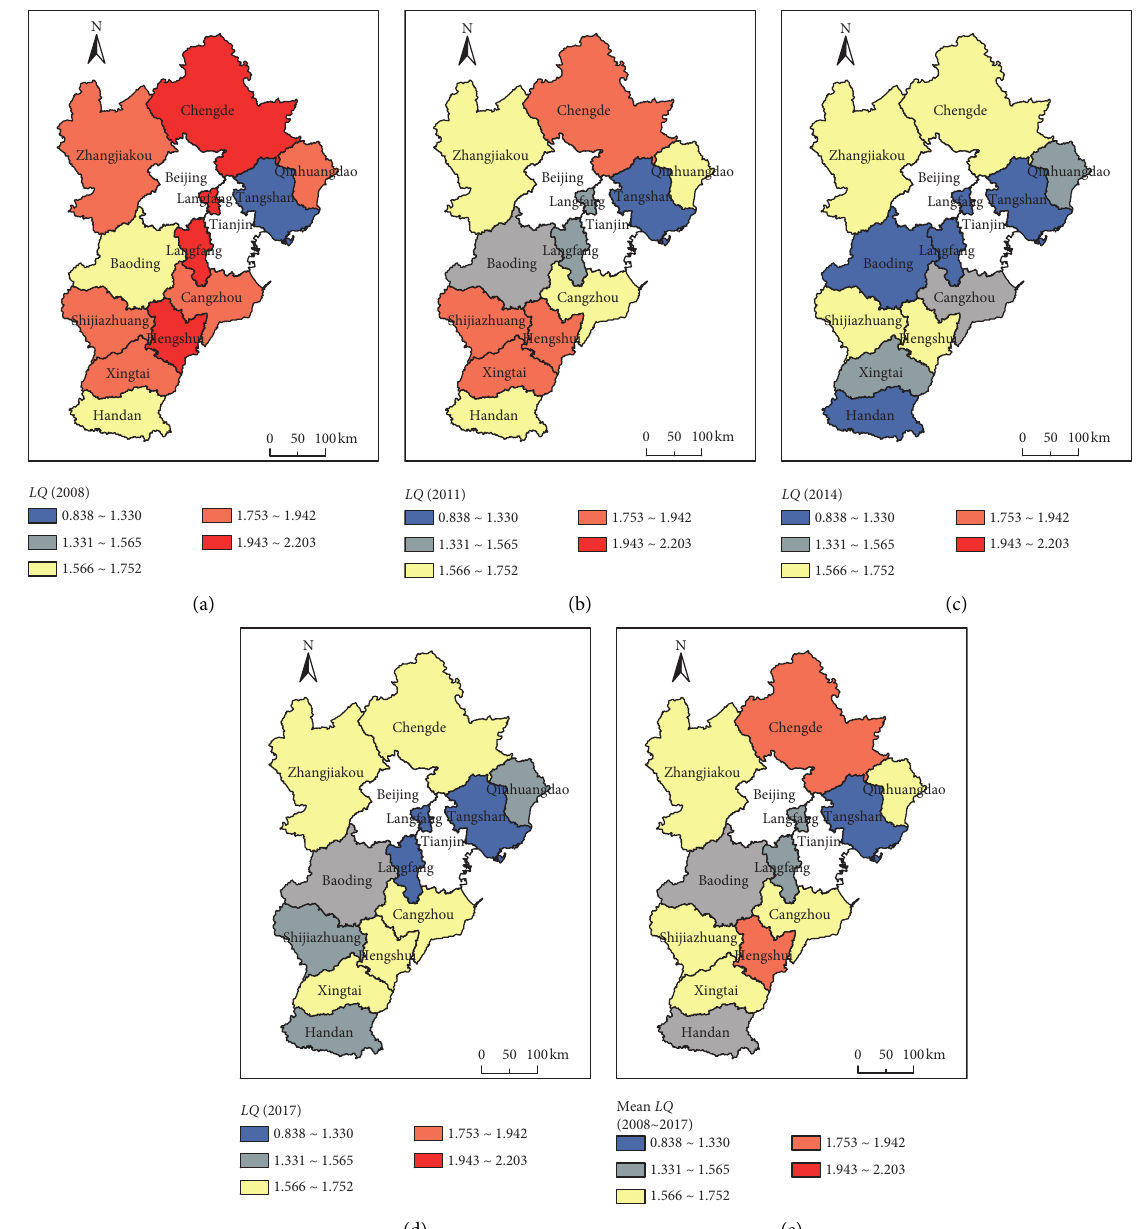
Figure 1: LQ of service industries of Hebei Province, China (2008, 2011, 2014, 2017, and